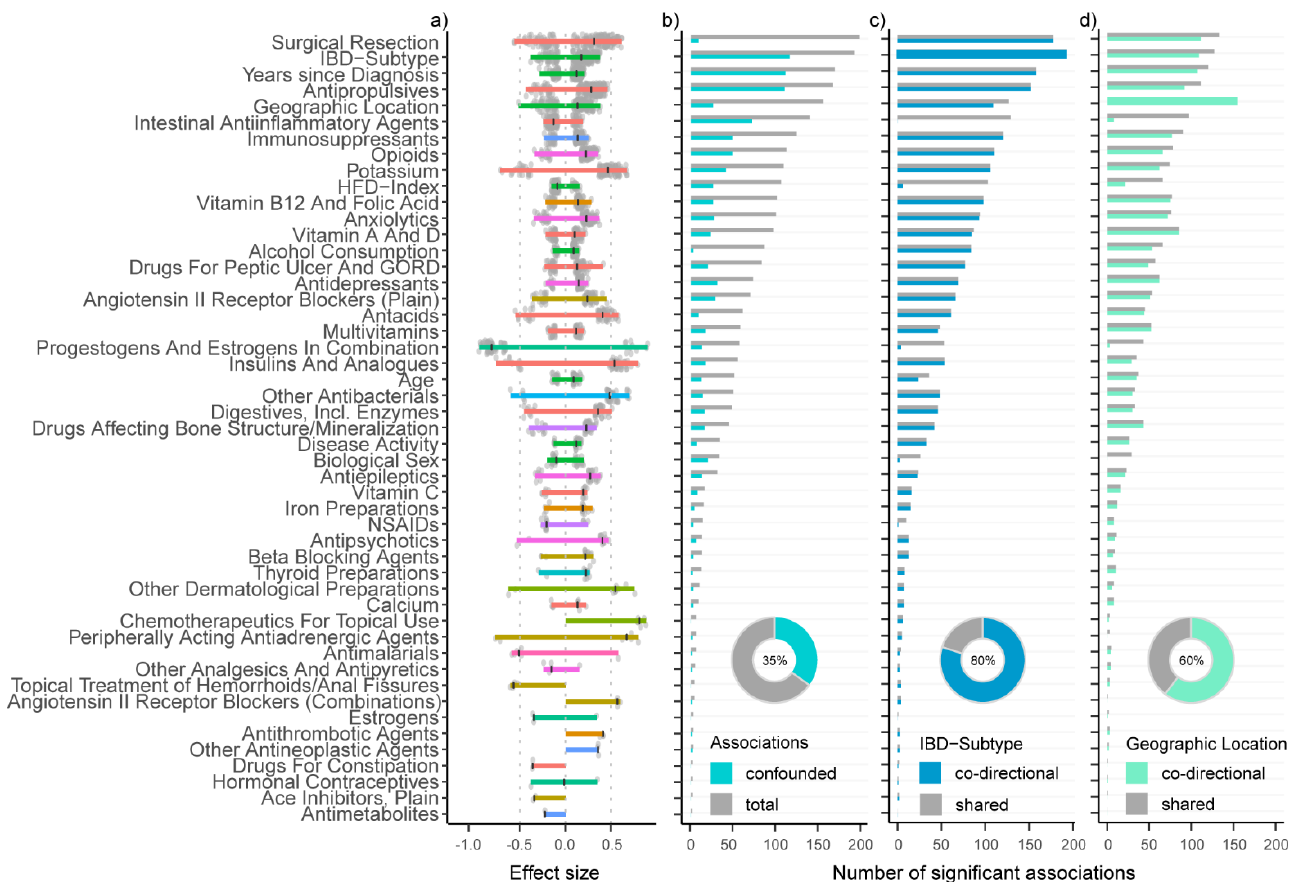
Figure 8. Effect sizes ( a ) and number of significant associations by metadata variable that are ( b ) confounded: ( c ) shared/co-directional with disease; and ( d ) shared/co-directional with geographic location.